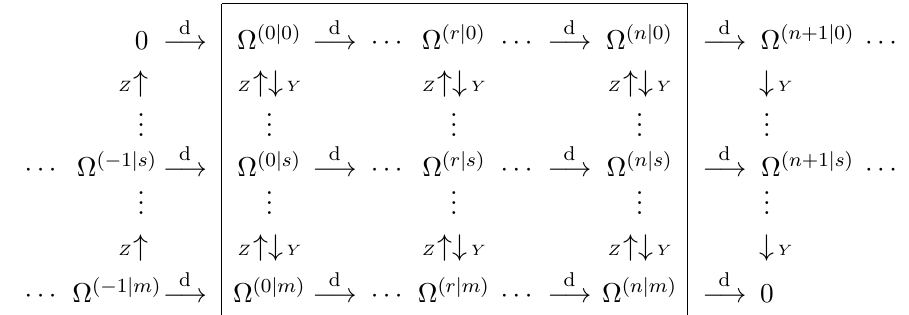
Figure 1 . Structure of the supercomplex of forms on a supermanifold of dimension ( m j n ) . The form degree r increases going from left to right while the picture degree s increases going from up to down. The rectangle contains the subset of the supercomplex where the various pictures are isomorphic in the cohomology of the d